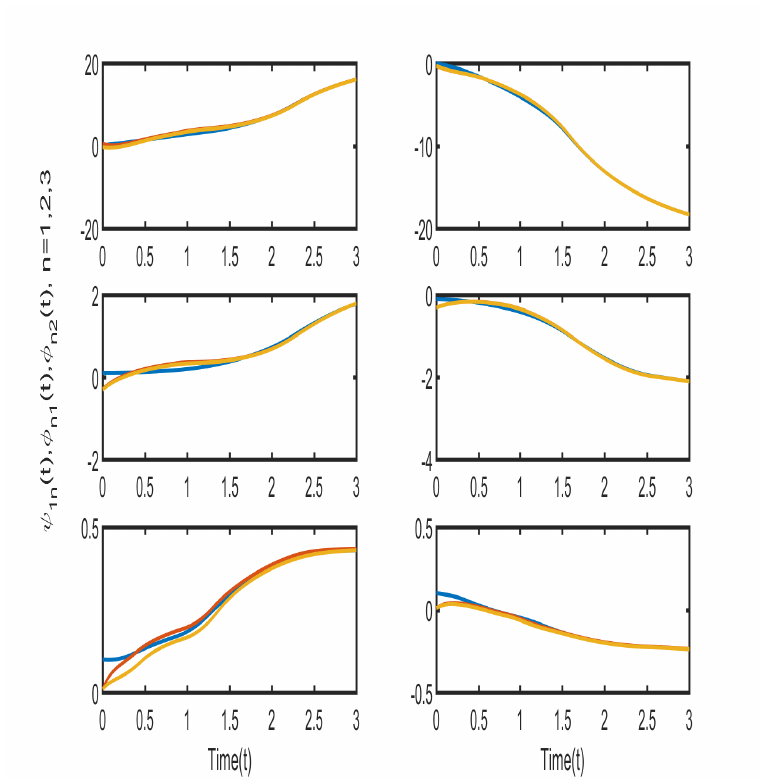
Figure 6. The real and imaginary parts of state trajectories of cluster one i.e., ( h = 1, i = 1,2 ) of CVNNs (23) and (24).